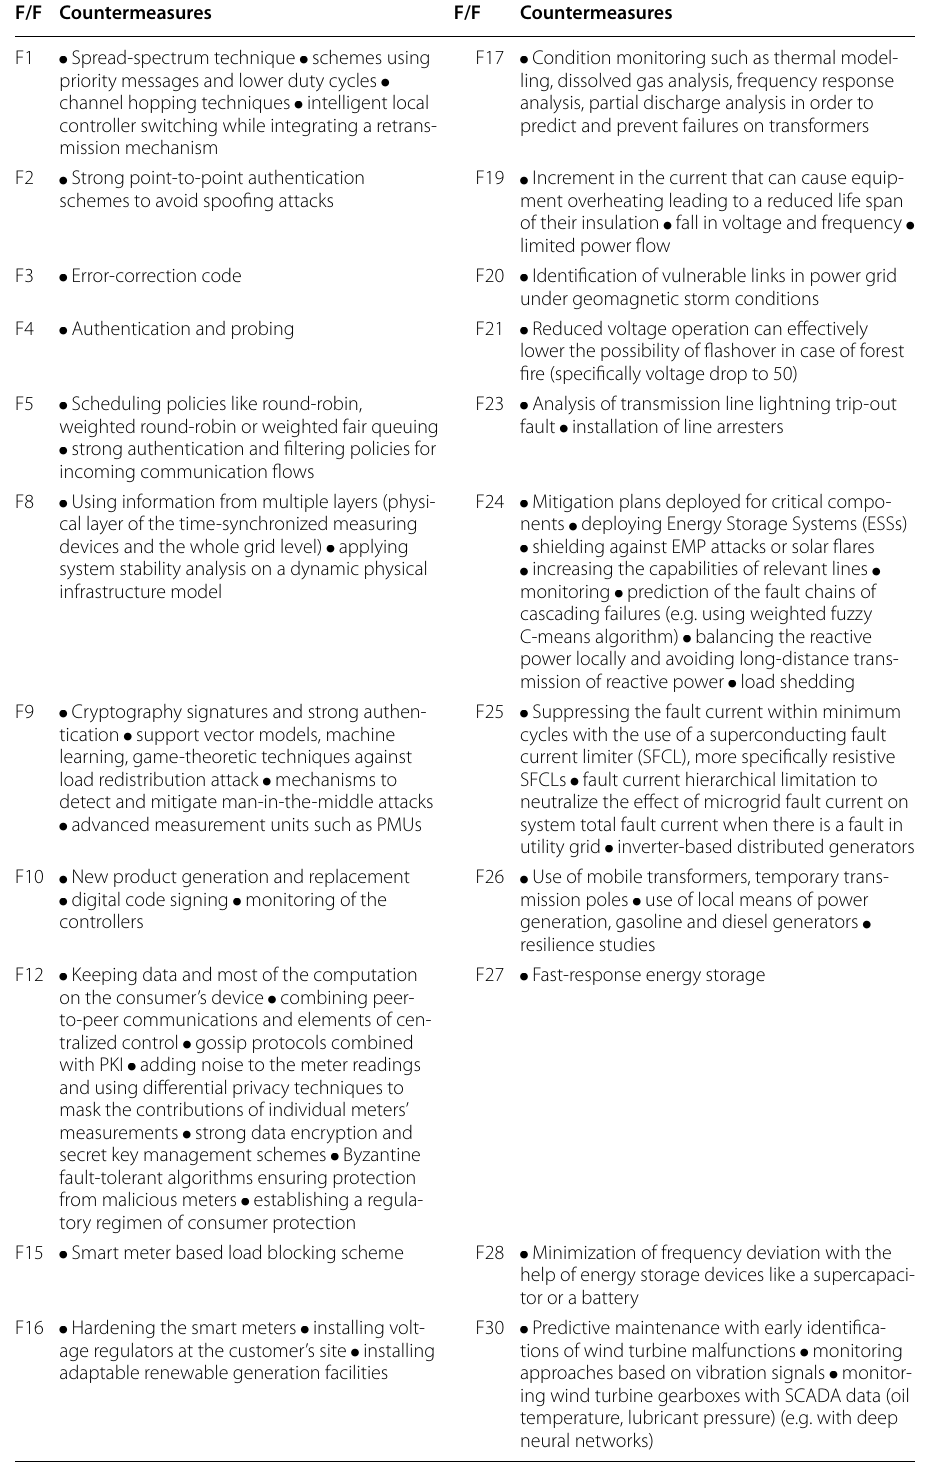
Table 6 RQ5 (Countermeasures for SG faults and failures) F/F